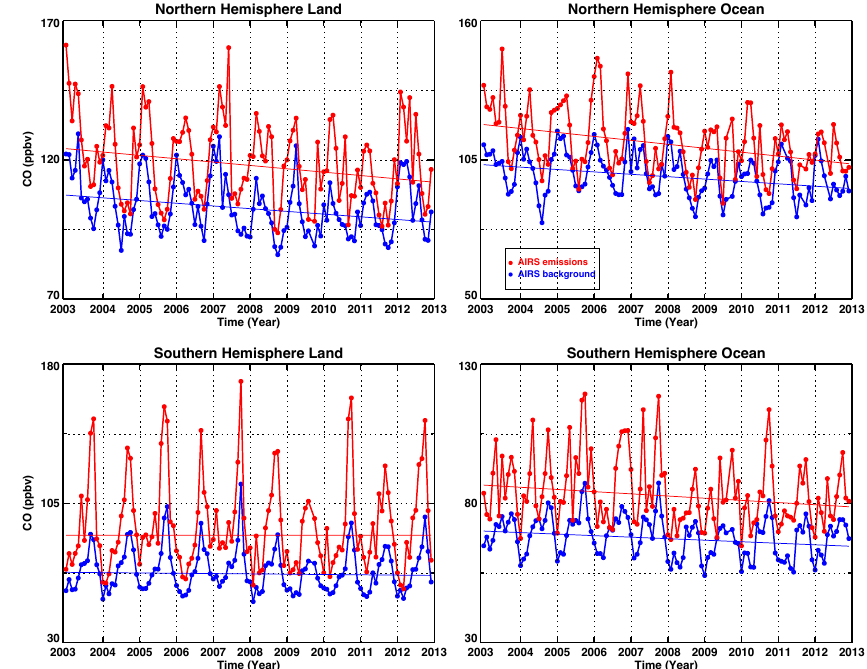
Fig. 7. Tropospheric CO variability at 500hPa from 2003 through 2012, which uses the modes of the fitted Gaussian functions for each monthly PDF to represent biases, for the recent emissions (red curves) and the background (blue curves), and for NH land (top left panel), NH ocean (top right panel), SH land (bottom left panel), and SH ocean (bottom right panel), respectively. rate of − 1.95 ppbv yr − 1 (emissions) and − 1.18 ppbv yr −